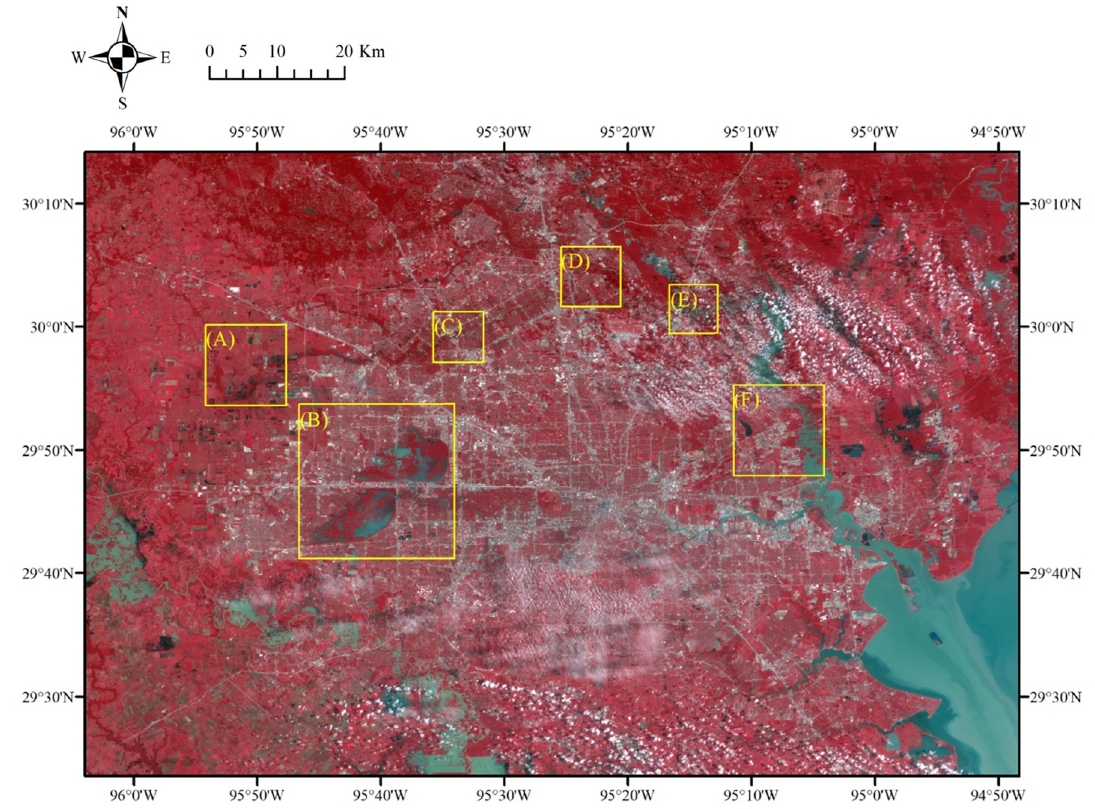
Figure 10. The DMCii image acquired on 1 September, along with boxes frames indicating flooded areas to be investigated.